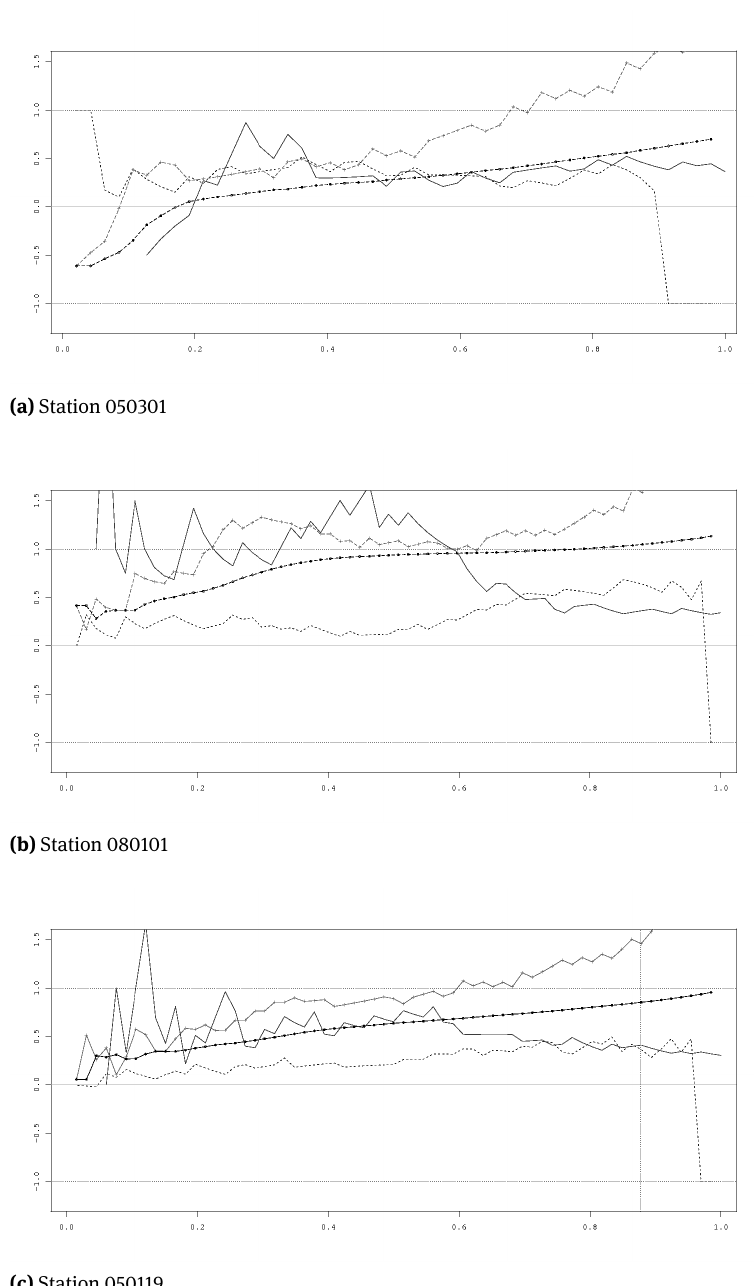
Figure 5: Estimators of the tail dependence function ¯ χ (.) of the pair ( Q , V ) . The vertical axis corresponds to ˆ¯ χ ( u ) with ˆ¯ χ COLES (- - - -), ˆ¯ χ D (—), ˆ¯ χ H (-+-+-) and ˆ¯ χ Z (- ◦ - ◦ -), while the horizontal axis corresponds to threshold u = k / n with U , k U , k U , k k = 1, . . . , n − 1 . In horizontal dotted line, the upper and lower bounds on ¯ χ (.) .